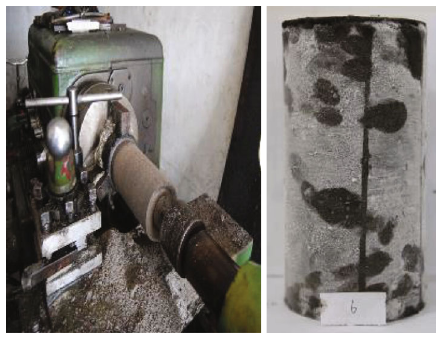
Figure 2: Oil sand core test specimen preparation process by lathe and the processed test specimen.